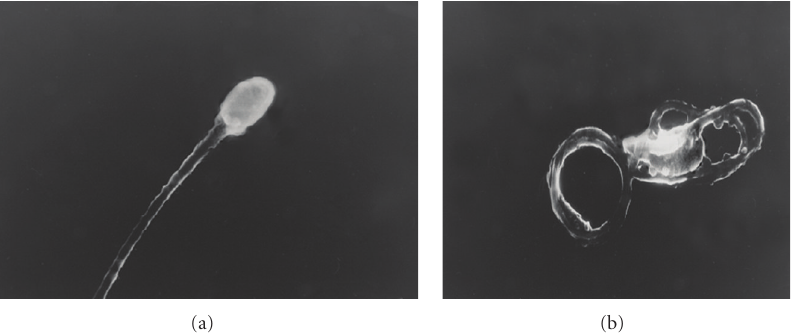
Figure 5: Scanning electron micrograph showing (a) normal washed human spermatozoa (X8, 000 magnification), (b) human spermatozoa on treatment with SIF showing curling of tail and morphological changes (X6, 000